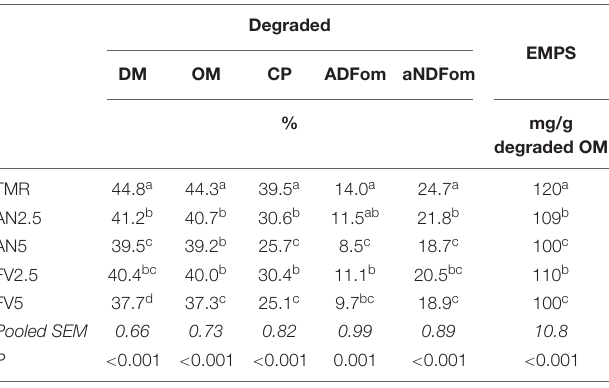
TABLE 3 | Nutrient degradation in the feed bags of the five treatments (days 7–12) and estimated microbial protein synthesis (days